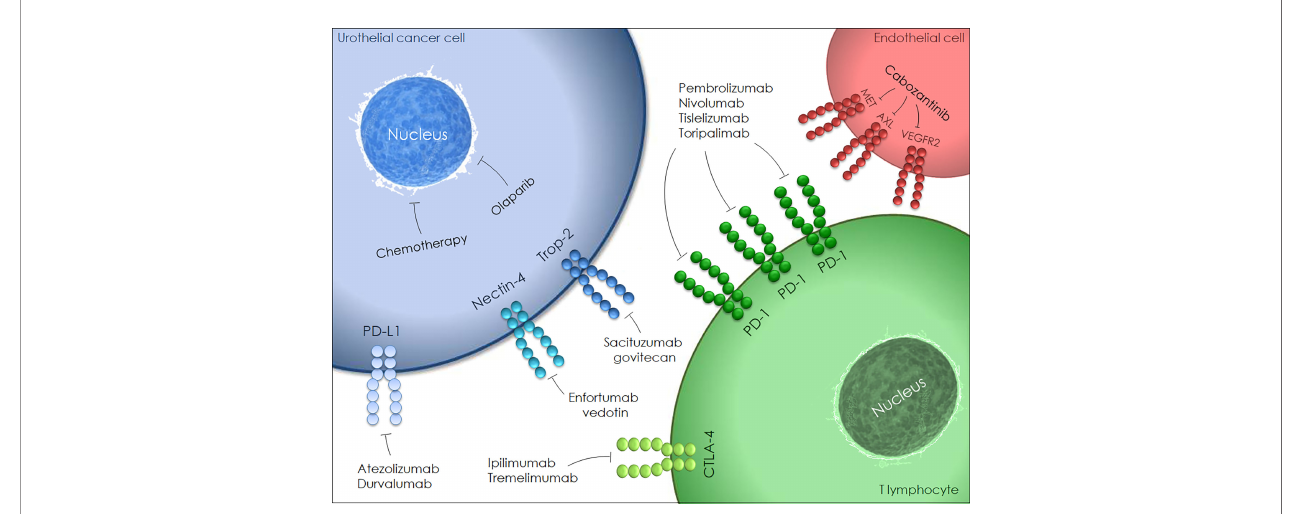
FIGURE 1 | Emerging agents in the context of neoadjuvant setting for patients with